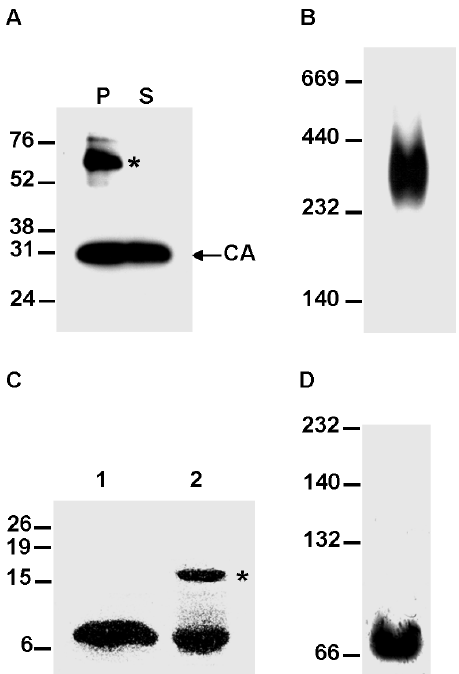
Figure 9. In vitro oligomerization ability of the FIV CA and FIV CA-CTD polypeptides. (A) Sedimentation analysis of the in vitro assembly reaction for recombinant FIV CA. The purified His-FIV CA protein was incubated under the conditions described in Materials and Methods and the assembly mixture was separated by centrifugation into the pellet (P) and supernatant (S) fractions which were then subjected to SDS-PAGE followed by Western blotting using an anti-FIV CA MAb. The asterisk indicates SDS-resistant CA dimers. (B) To examine the oligomeric arrangement of the FIV CA, an aliquot of the in vitro assembly reaction for the recombinant FIV CA protein was analyzed by native gel electrophoresis (5% non-denaturing polyacrylamide gel) followed by Western blotting using an anti-FIV CA antibody. (C) Electrophoretic analysis of the FIV CA- CTD polypeptide under denaturing conditions. The His-tagged FIV CA-CTD protein was purified by affinity chromatography, digested with enterokinase, and run on an SDS-polyacrylamide gel in Laemmli loading buffer with (lane 1) or without SDS (lane 2) followed by staining with Coomassie G-250. The asterisk denotes dimers of the FIV CA-CTD. (D) Assembly reaction for the FIV CA-CTD polypeptide. The recombinant FIV CA- CTD protein was incubated under the same conditions used for the FIV CA and the assembly mixture was then analyzed by Western blotting of native gels using the anti-FIV CA MAb. The migration positions of the molecular mass markers (in kDa) for the denaturing (A and C) and native (B and D) gel electrophoresis are indicated on the